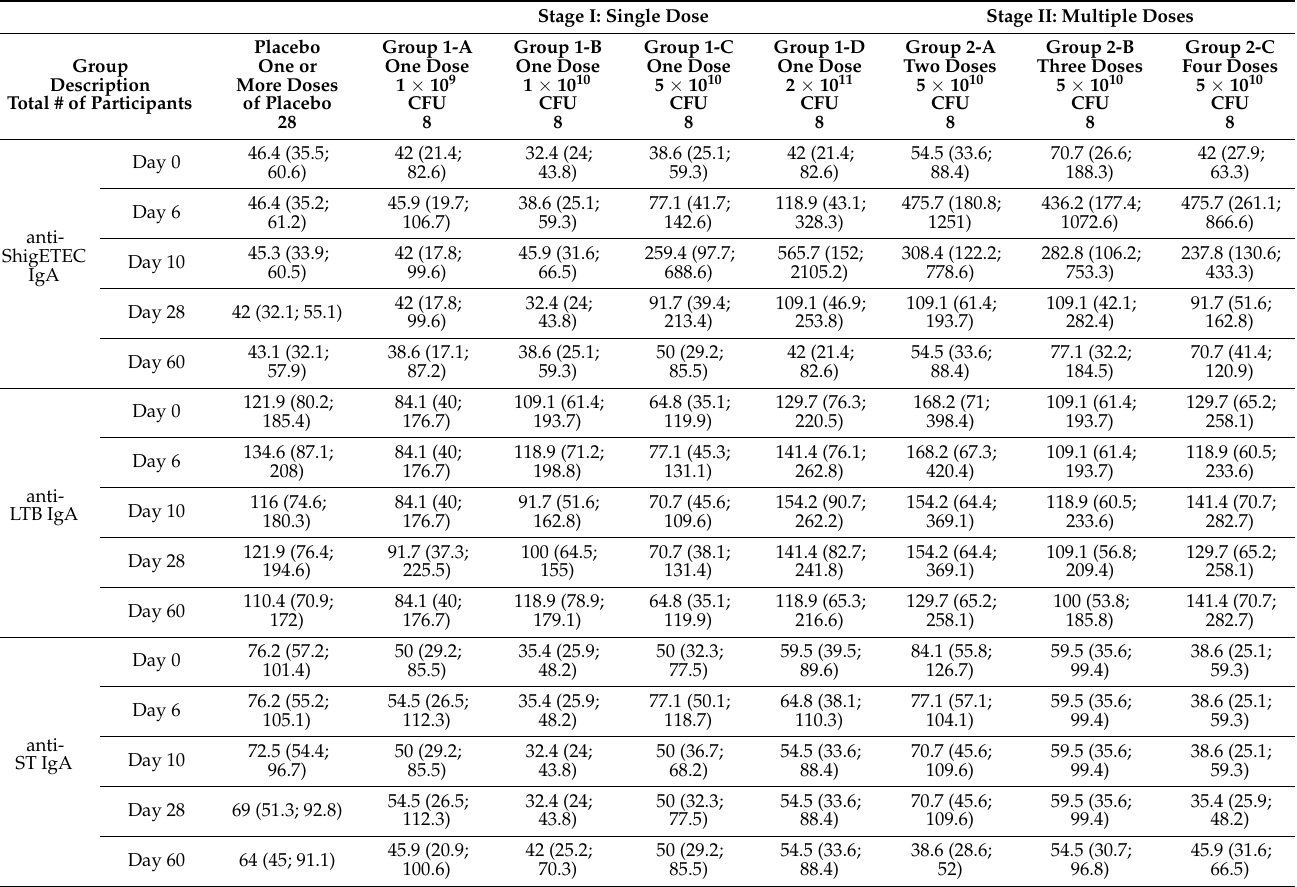
Table A1. Geometric mean titer (GMT) of IgA antibodies against ShigETEC, LTB and ST in serum. GMT and 95% confidence interval (in brackets) are given for indicated time points and antigens. Stage I: Single Dose Stage II: Multiple Doses